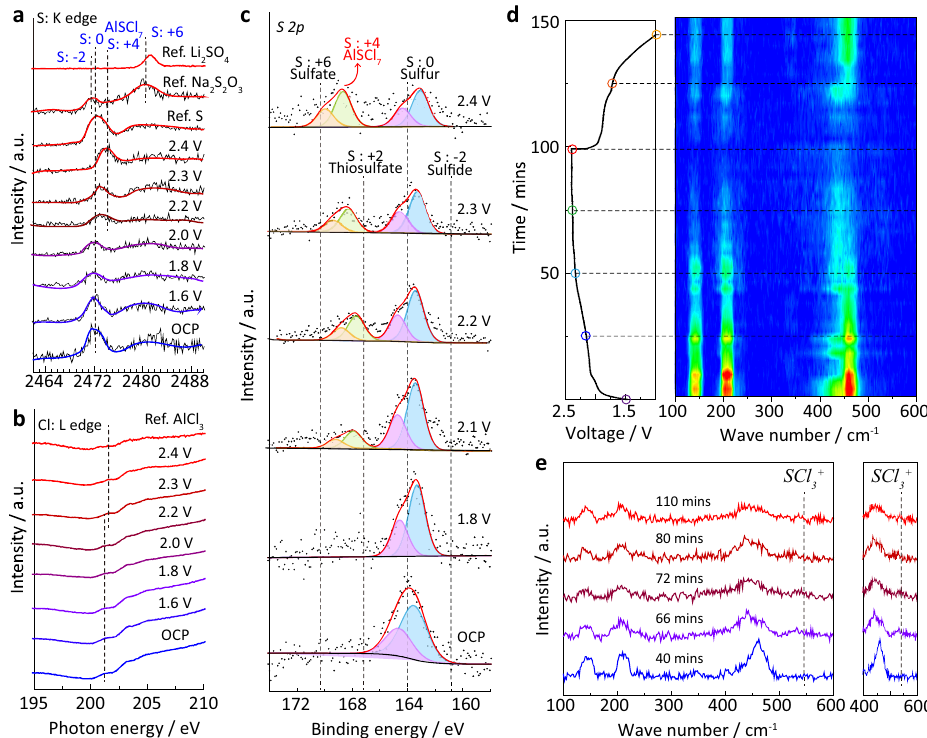
Fig. 4 Identi fi cation of oxidized intermediates of sulfur via spectroscopic analysis. NEXAFS spectra of S/CNT cathode with different voltages recorded at the a S K -edge and b Cl L -edge; c the S 2p XPS spectra of S/CNT cathode at different oxidation voltages; the Al – S batteries were charged from open-circuit potential (OCP) to 2.4 V at 0.2 A g − 1 , and then the S/CNT cathodes at different cut-off voltages were extracted from the disassembled Al – S batteries for NEXAFS and XPS investigations; d the charge – discharge curves of Al – S batteries at 0.2 A g − 1 and their real-time Raman contour map for S/CNT cathode; e Raman spectra at different times extracted from the contour pattern in d